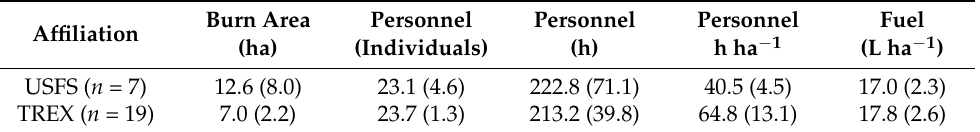
Table 3. Average Personnel Hours and Fuel Used by Prescribed Burn Managers by Affiliation in the Klamath Watershed. Personnel hours were calculated by multiplying the time spent at a burn site by the total personnel conducting the burn. Personnel included all staff including burn bosses and wildland fire crews. USDA Forest Service (USFS) burns were conducted on the Klamath and Six Rivers National Forests in 2017. Prescribed Fire Training Exchange (TREX) burns were observed from 2017–2019. Standard errors ( ± ) shown in